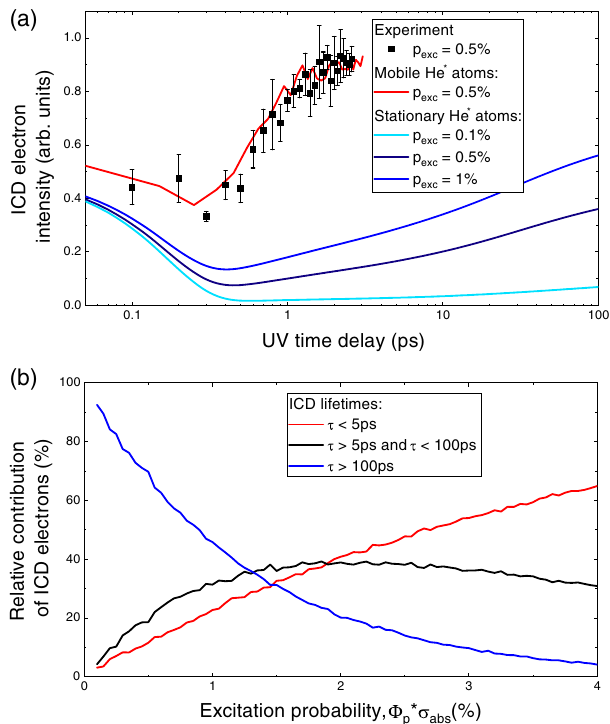
FIG. 8. (a) Simulated ICD electron intensities as a function of the UV time delay for fixed He (cid:2) positions with different excitation densities (blue curves). For comparison, the exper- imental data are shown as black squares, and the corresponding MC simulation assuming mobile He (cid:2) atoms is shown as a red line. (b) Relative contribution of ICD electrons broken up into three different ICD lifetime intervals as a function of excitation probability for fixed He (cid:2)